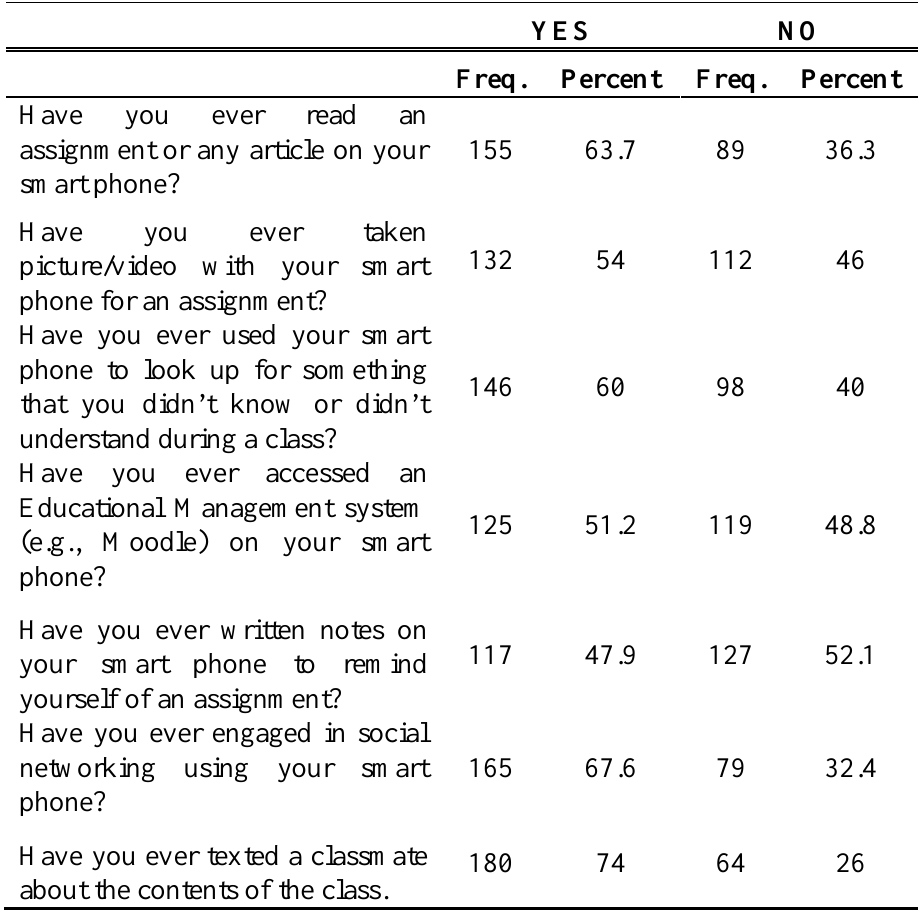
Current Education Related Usage of